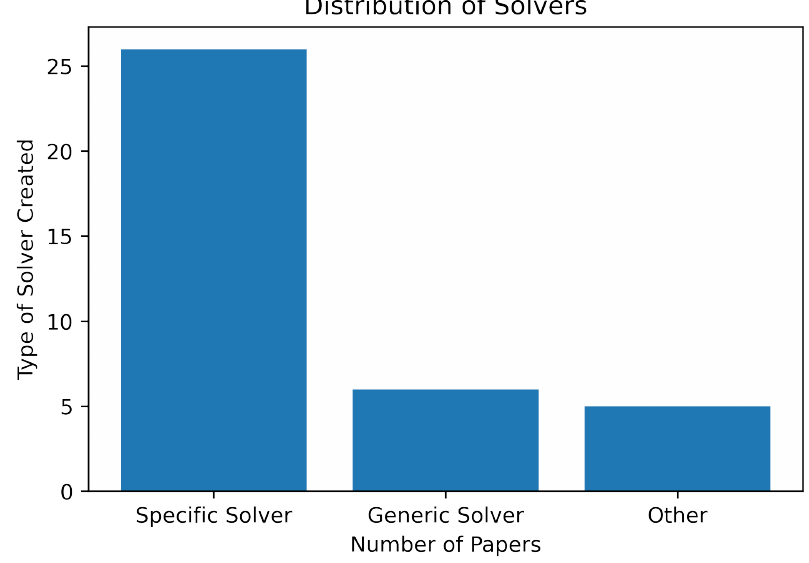
Figure 1. The distribution of papers based on whether they create a generic model or a specific